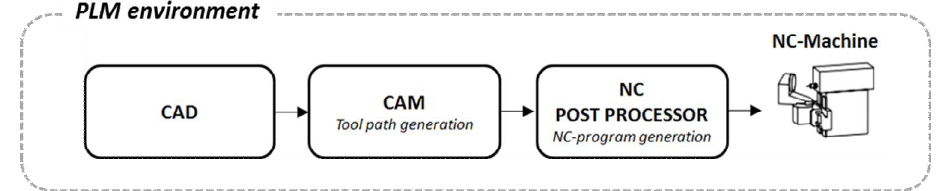
Figure 2. Tool chain to be adopted (prerequisites). PLM, Product Lifecycle Management; CAD, computer-aided design; CAM, computer-aided manufacturing; NC, numerical control.